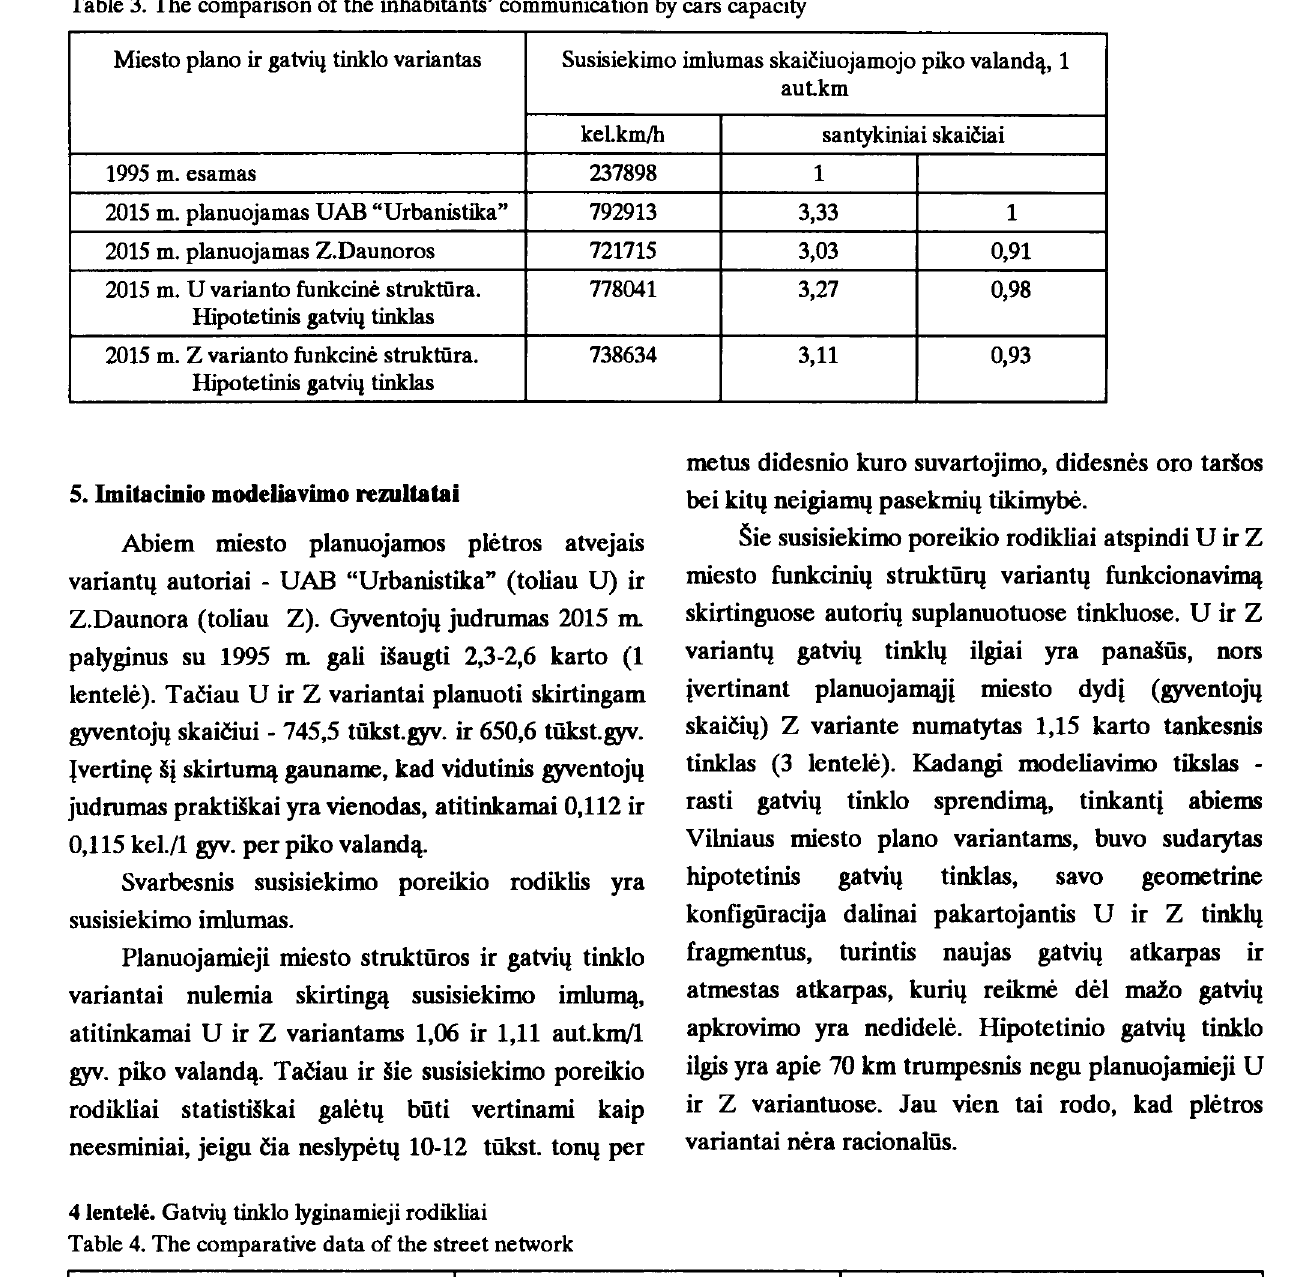
Table 4. The comparative data of the street network